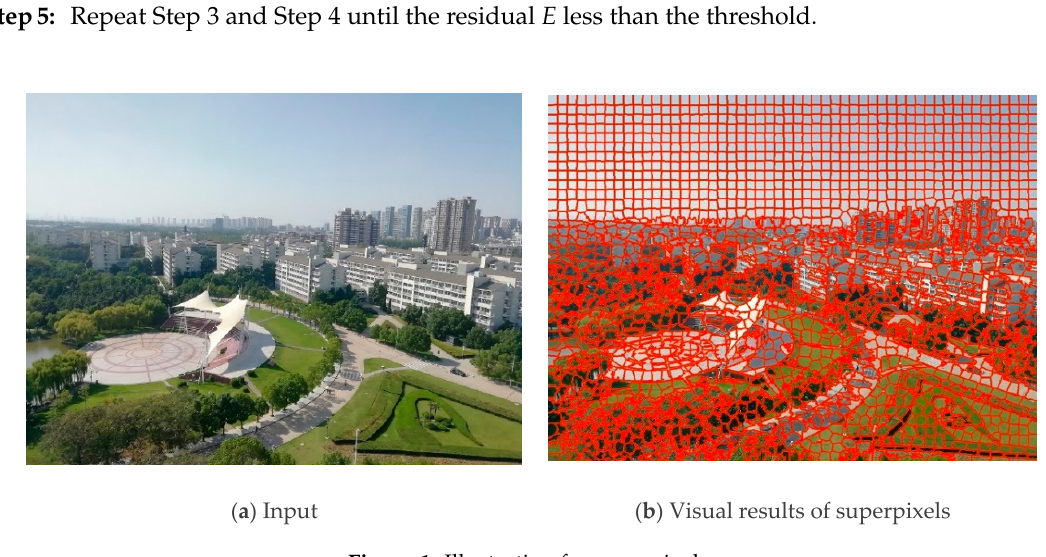
Figure 1. Illustration for superpixels.